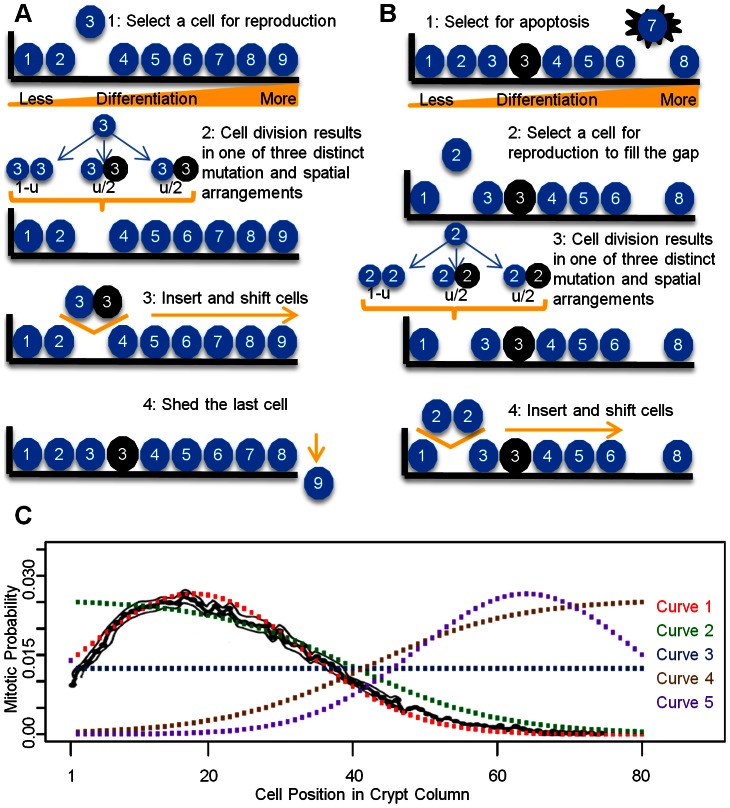
Schematics of the linear process and proliferation kinetic curves.A: We designed a linear process model to describe the essential features of cell movement in a colonic crypt. During each time step, a cell at position i is selected to divide. During mitosis, a mutation may occur with probability u, giving rise to one mutated and one wild type daughter cell, with equal probability of occupying either position i or i+1. Cell division pushes all cells to the right of position i upwards in the crypt by one position. The last cell is shed into the lumen of the colon. B: Cell death may occur after each round of cell division. The number of dying cells follows a Poisson distribution with mean λ; the positions of the dying cells are selected according to a uniform distribution. Dead cells are replaced by replenishing cell divisions. Dying cells at position j can only be replaced by cells of a similar (j+1≤k≤j+δ) or less (k<j) differentiated stage. Position k is selected according to the proliferation kinetics curve. If multiple cells die simultaneously, the replenishing cell divisions occur sequentially, in the order of j(1), j(2) … j(m), where j(1), j(2) … j(m) are ordered death position. The m positions for the replenishing cell divisions are selected according to the reweighted kinetic curve. C: Proliferation kinetic curves as a function of cell positions. The black curve represents the measured labeling index for normal human colon using bromodeoxyuridine (BRDU) [23]. The colored curves represent the five kinetic curves under investigation. See the Methods section for details. Note that curve 1 is in good agreement with the measured labeling index.